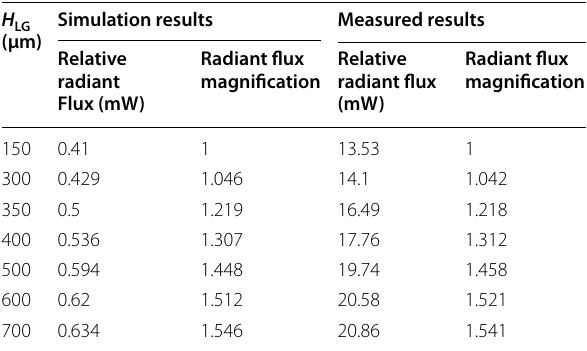
Table 4 Difference between simulated and measured LEE of UV‑C LEDs with light guide layer thicknesses of 150–700